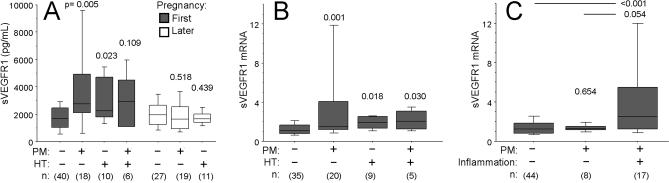
sVEGFR1 Expression Levels in PM-Positive and PM-Negative Women(A) Peripheral plasma sVEGFR1 levels (median [IQR]). Levels are indicated for mothers stratified by parity, PM, and hypertension (HT).(B and C) Placental sVEGFR1 mRNA abundance (median [IQR]) in first-time mothers. Levels indicate fold-increase over trophoblast-specific cytokeratin 7 (KRT7) mRNA. Women were stratified (B) by PM and hypertension or (C) by PM and intervillous inflammation.